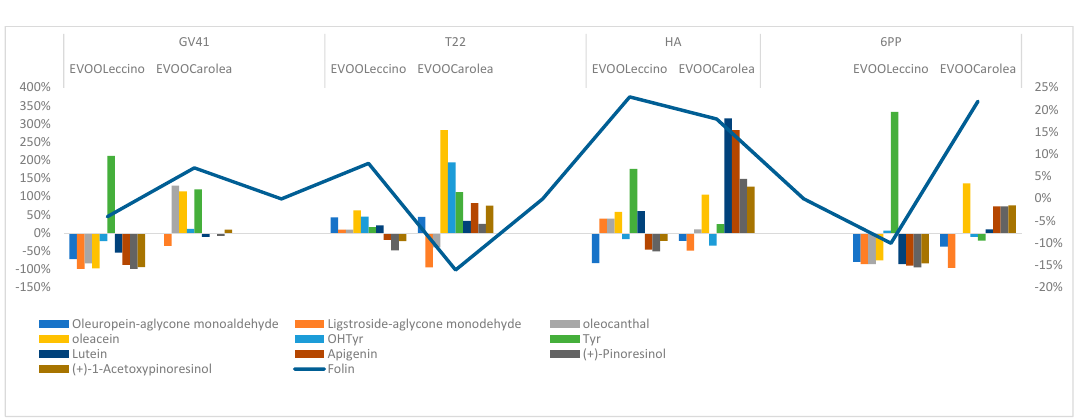
Figure 7. Variation (%) of the phenolic class of compounds and total phenol content in the EVOO samples. Figure7.